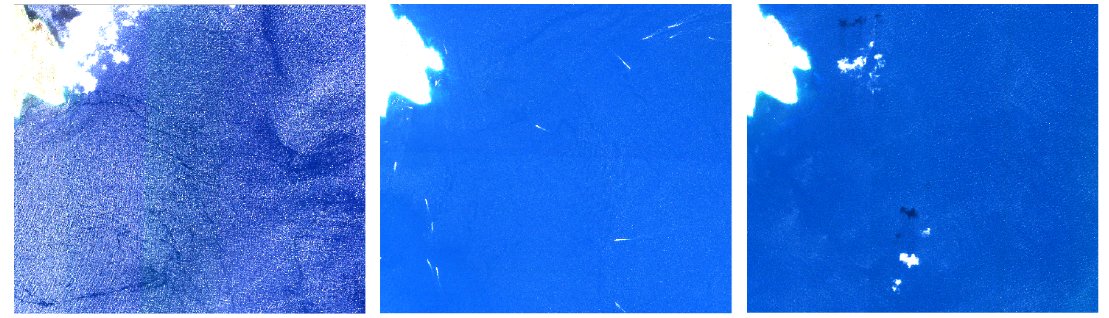
Figure 8: A stretched true-color composite of the WV-3 image acquired on 25.08.2015 (left), WV-2 image acquired on 30.08.2015 (center) and WV-2 image acquired on 10.09.2015 (right).